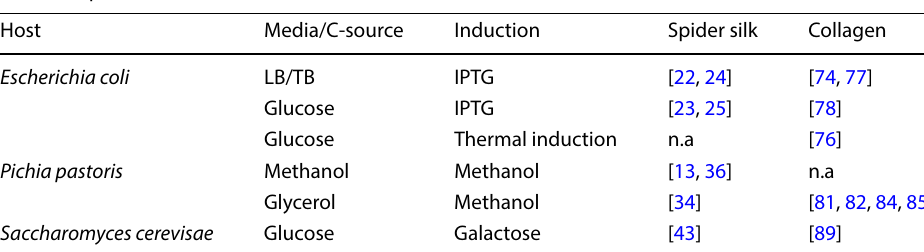
Protein expression Host Media/C-source Induction Spider